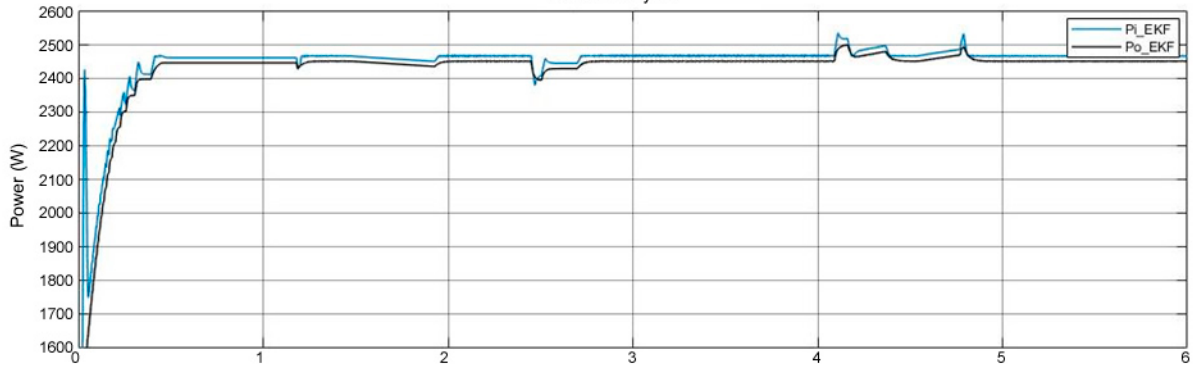
Figure 9. Input and output power curves of two − phase IBC.